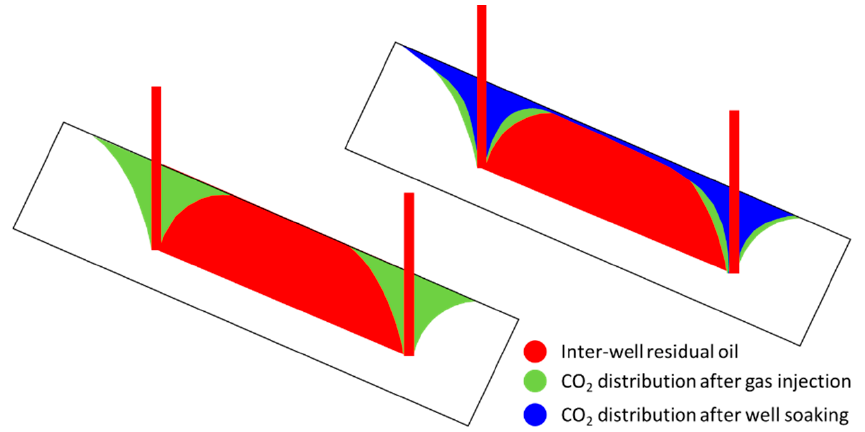
Figure 1. Schematic diagram of horizontal well synergistic CO 2 huff and puff.